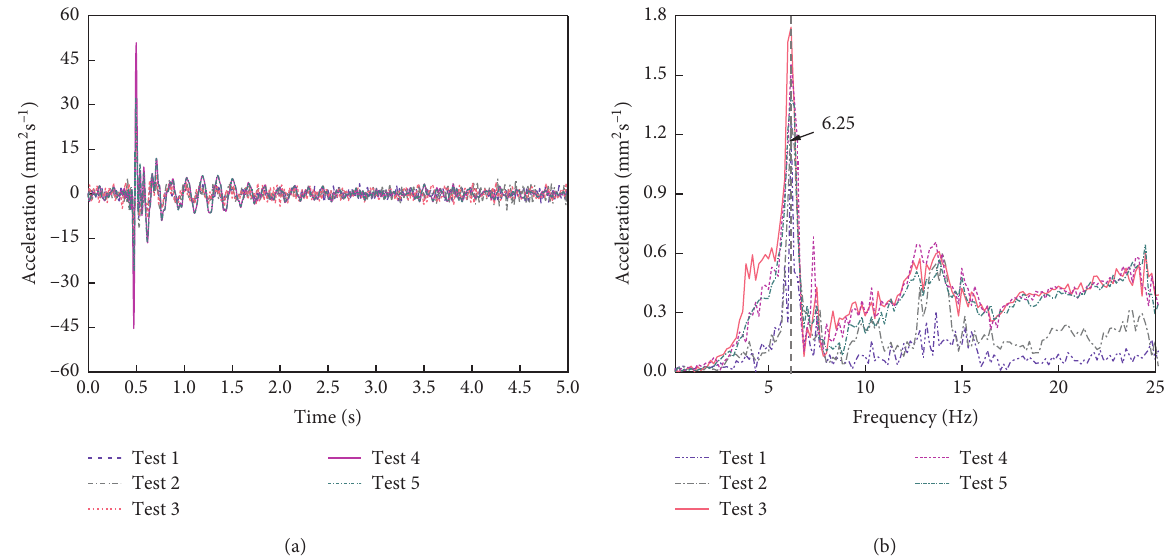
Figure 7: Typical time-domain curve and frequency-domain curve induced by single-person heel-drop tests: (a) acceleration responses; (b) corresponding power spectrum.